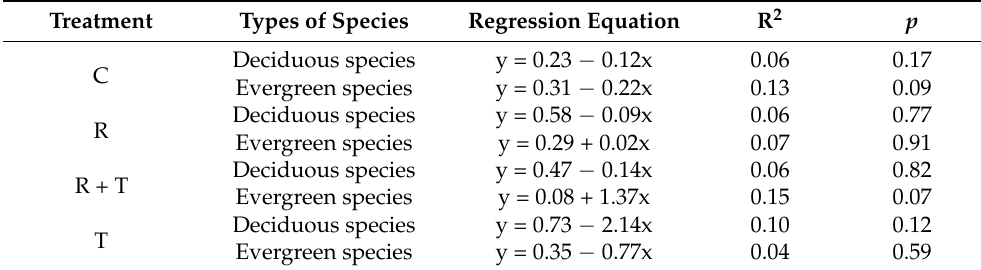
Table 3. Linear regression equation parameters of the seedling relative growth rate and root